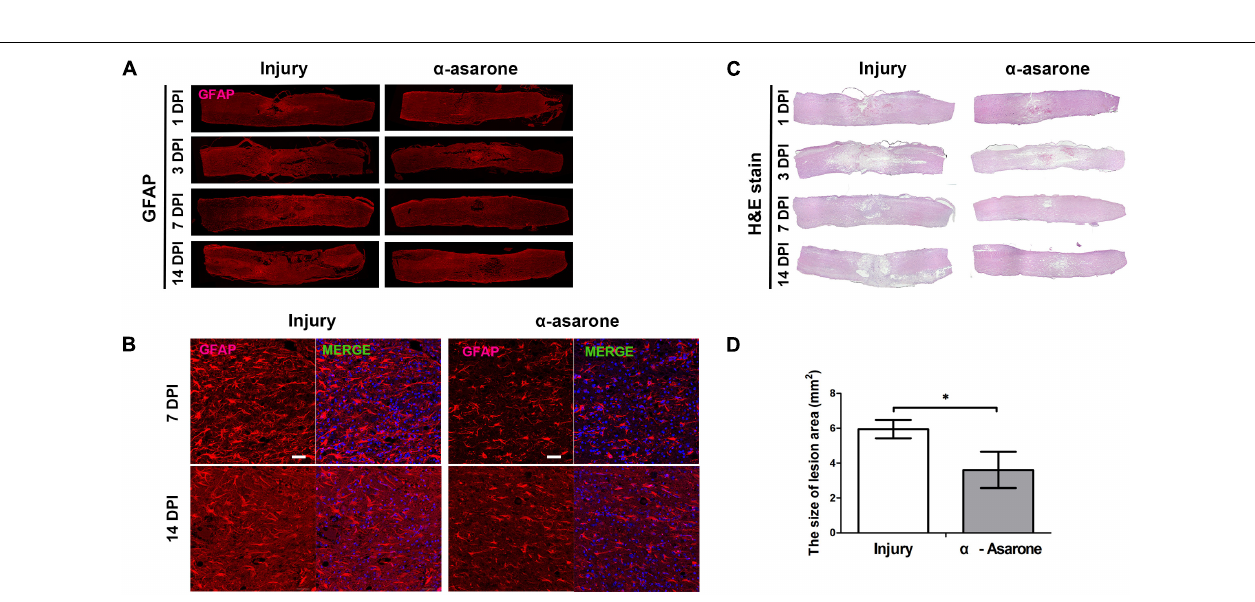
FIGURE 5 | Histopathological and immunohistochemical analyses of the spinal cord. (A) Immunolabeling for GFAP (red, glial fibrillary acidic protein) of longitudinal sections of spinal cords from rats subjected to spinal cord injury (Injury) or α -asarone treatment following injury ( α -asarone). DPI, days post injury. Spinal cord length size, 1 cm. (B) Histological findings were based on hematoxylin-eosin staining of longitudinal sections of spinal cords from rats in the Injury or α -asarone group, respectively. (C) Immunolabeling for GFAP (red) and DAPI (4 (cid:48) ,6-diamidino-2-phenylindole) nuclear staining. Scale bars, 50 µ m. (D) The graph shows the mean area of scar in mm 2 ± SD after 14 days following SCI ∗ P < 0.05, one-tailed Student’s t -test ( n = 6).